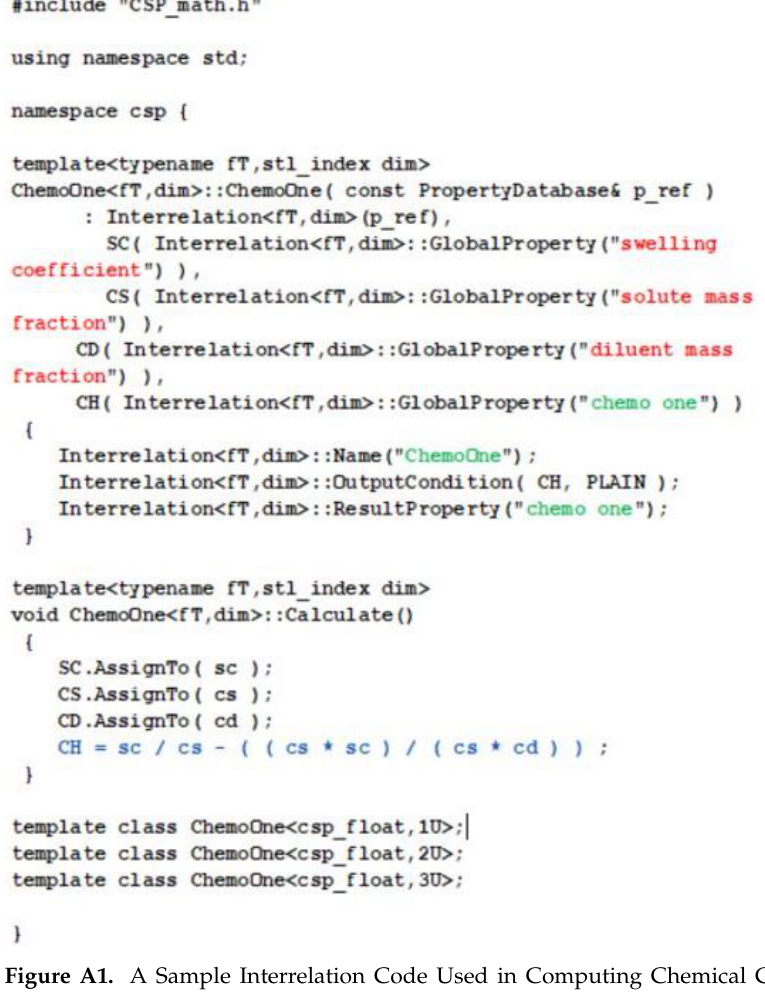
Figure A1. A Sample Interrelation Code Used in Computing Chemical Coupling Coefficient 1